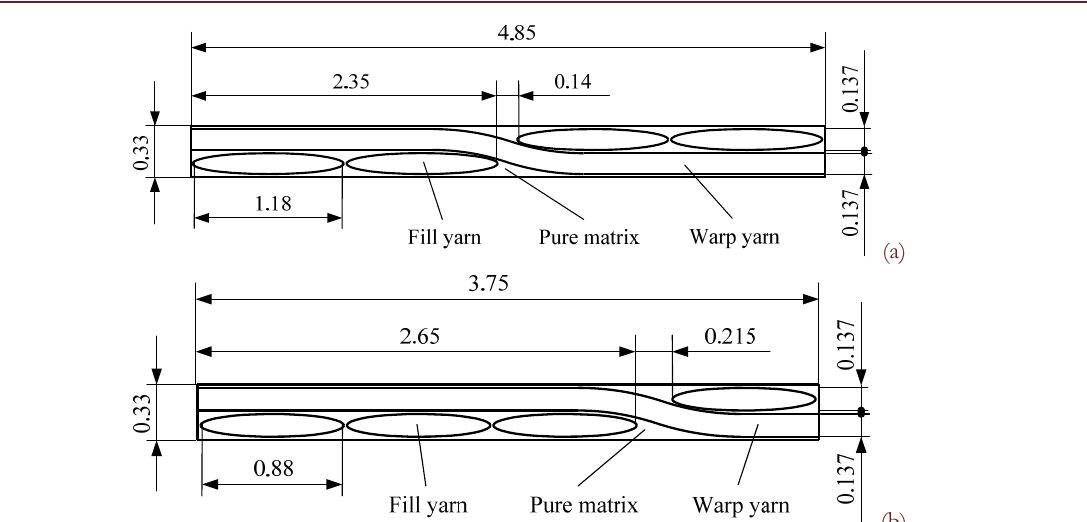
Figure 4: Schematic depiction of sample cross-sections for the two types of dry fabric reinforcements. (a) Twill wave 2/2; (b) Twill weave 1/3.